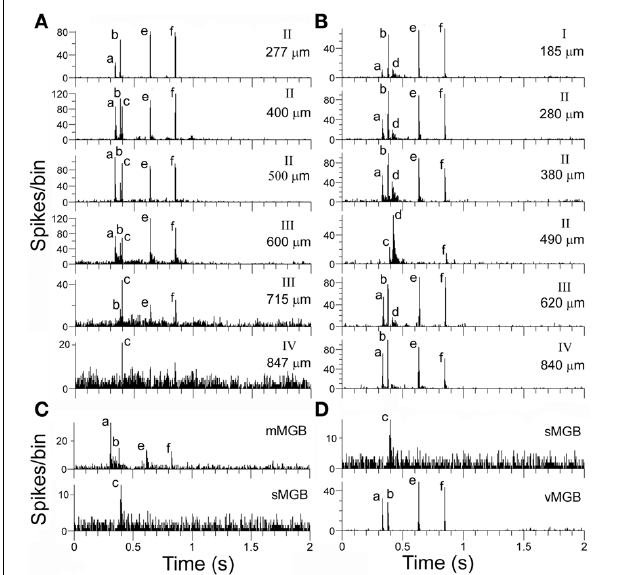
FIGURE 10 | (A, B) Responses from a series of units from two separate orthogonal tracks in AI(LF). The depth of each unit and the probable cortical layer are indicated at the right of each panel. (C) The top histogram shows the response of a unit in the medial MGB that corresponds to the response of the first unit in the cortical track (A) while the bottom panel shows the response of a unit in the shell MGB that corresponds to the response of a unit that may be in layer IV. The cortical units recorded in the middle of track (A) appear to show a summating convergence of the responses recorded at the top and bottom of the track although the response at 715 µ m also appears to have an initial strong suppression of any response. Responses of track (B) units in layer IV (840 µ m) and layer II (490 µ m) correspond to responses found in the MGB and shown in (D) . Other units in the track again seem to show a summative